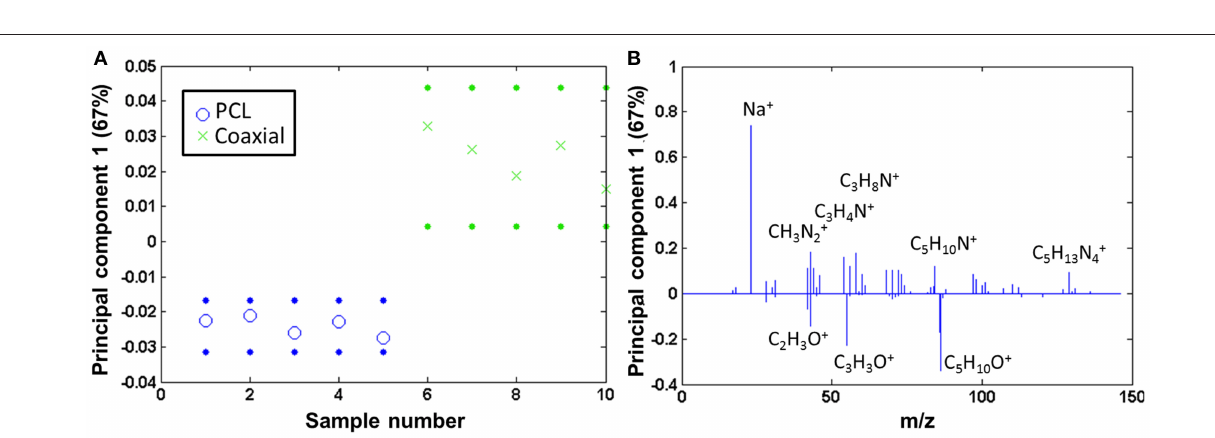
FIGURE 6 | PCA comparing the fibronectin coated samples to linker coated PCL: scores (with 95% confidence limits; dotted lines) of (A) PCL Hy and (B) PCL EN mediated protein adsorption; (C,D) corresponding loadings.